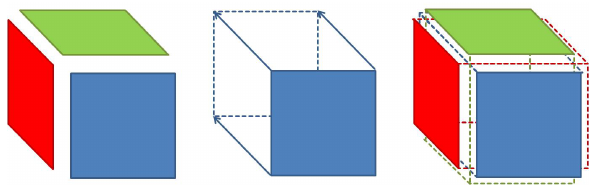
Figure 2: Definition of SVPs: (left) 3D patches, (middle) an SVP with hypothetical extrusion and (right) the intersection of